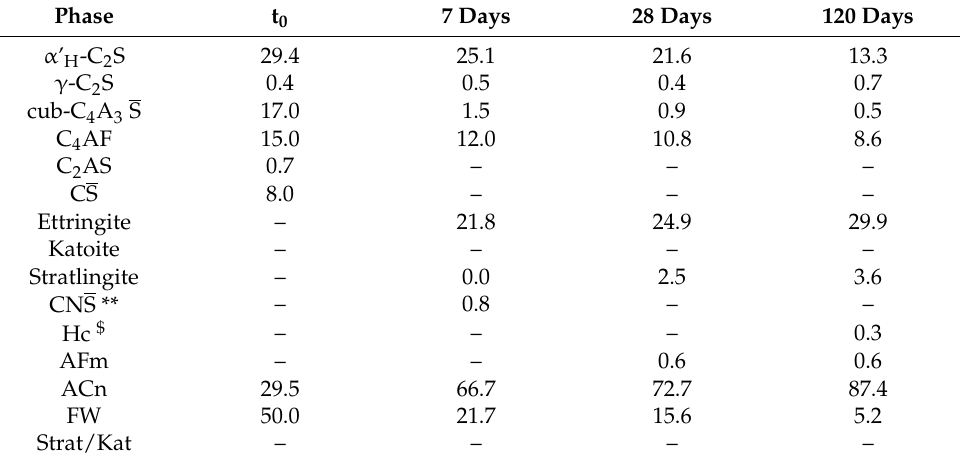
Table 7. RQPA, including ACn and FW of B-BYF with w/c = 0.50 and 0.3 wt % of SP (B-BYF- wc050_03SP), per 100 g of anhydrous cement. Stratlingite/katoite ratio is also